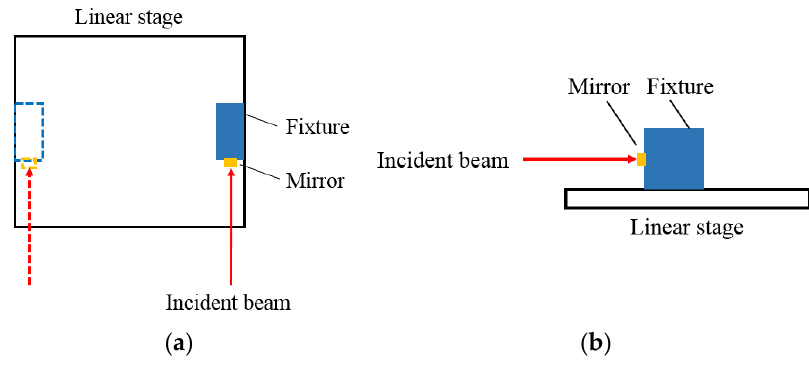
Figure 4. Coarse alignment: ( a ) top view and ( b ) side view.